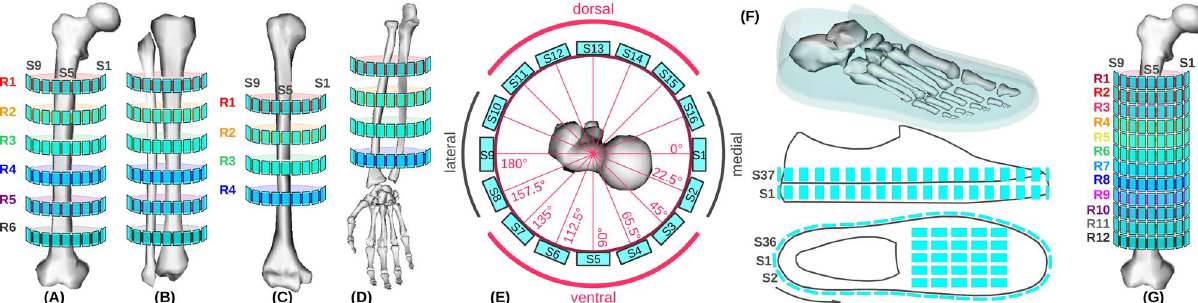
Figure 9. Illustration of simulated sensors. Coloured ring numbers ( Rx ) indicate vertical position along the bone. Designators Sx show identification numbering around objects, where only visible sensors are indicated. ( A ) Femur in ventral orientation. ( B ) Tibia and fibula in ventral orientation. ( C ) Humerus. ( D )Radius/ulna. ( E ) Per ring, 16 sensor positions are uniformly distributed, shown in top-view for the femur. ( F ) Sensor positions at the virtual shoe, including two rows with a total of 72 sensors and 25 additional sensors on the instep. ( G ) Femur for Case Study 2, where 12 rings with a total of 192 simulated sensors at each upper leg are